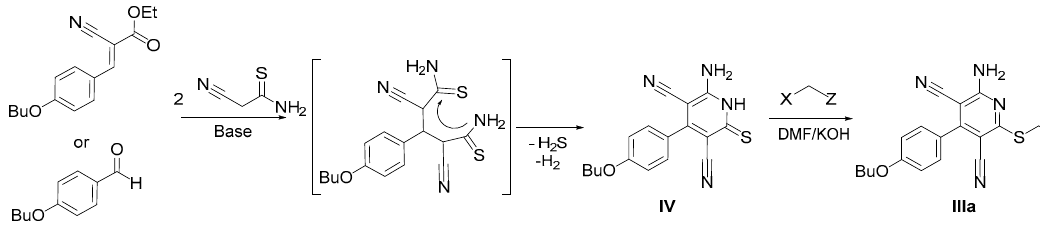
Figure 3. Mechanism proposed by Dychenko and Litvinov for the cyclization formation of 3,5-dicyano pyridine derivatives. X = Br, Cl; Z = 4-Cl-Ph, CH 3 COO, PhCO, CH 2 ⁼ CH, NH 2 CO, H, 4-Br-PhCO, 4-Cl- PhCO, EtCOO, PhCH 2 COO, 2-oxo-3-pyrazynylcarbonyl, PhNHCO, CN; B = N-methylmorpholine. A different methodology was used by Evdokimov and colleagues, who prepared a series of 2- amino-3,5-dicyano-6-sulfanylpyridines and 1,4-dihydropyridines via a single-step, three-component reaction of malononitrile with different aldehydes and thiols (Scheme 2) [86].